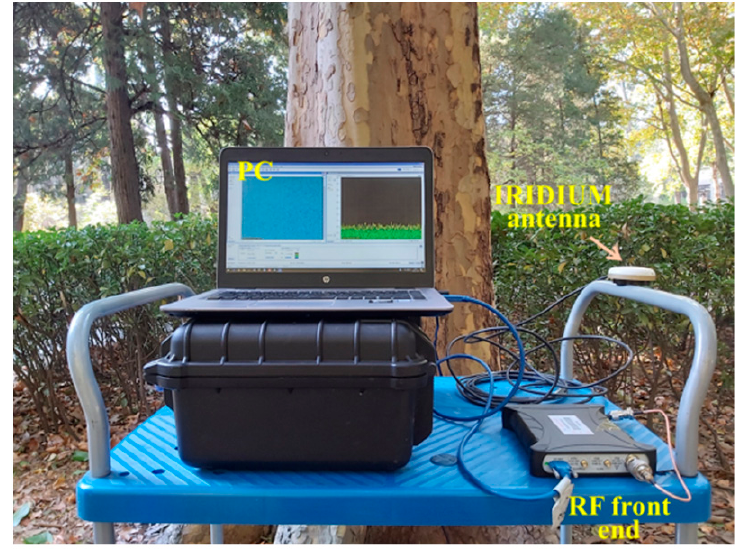
Figure 4. IRIDIUM NEXT data collection in weak signal environment.